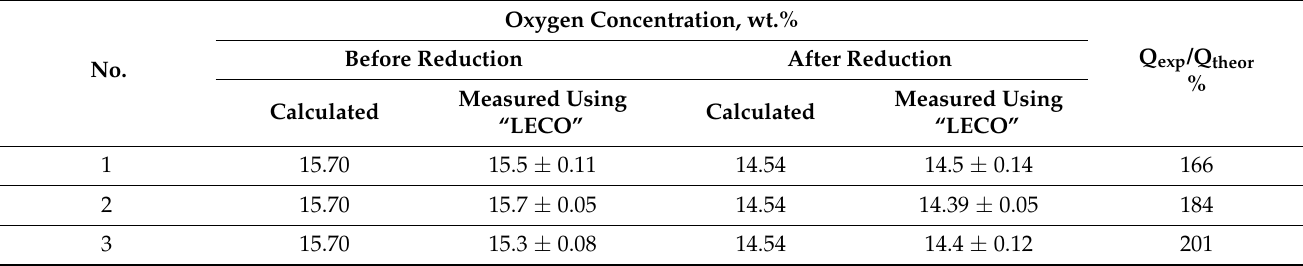
Table 7. Calculated and experimental values of the oxygen concentration in mixed REM (La 2 O 3 - CeO 2 ,-Nd 2 O 3 ; 1:1:1) pellets before and after the reduction.